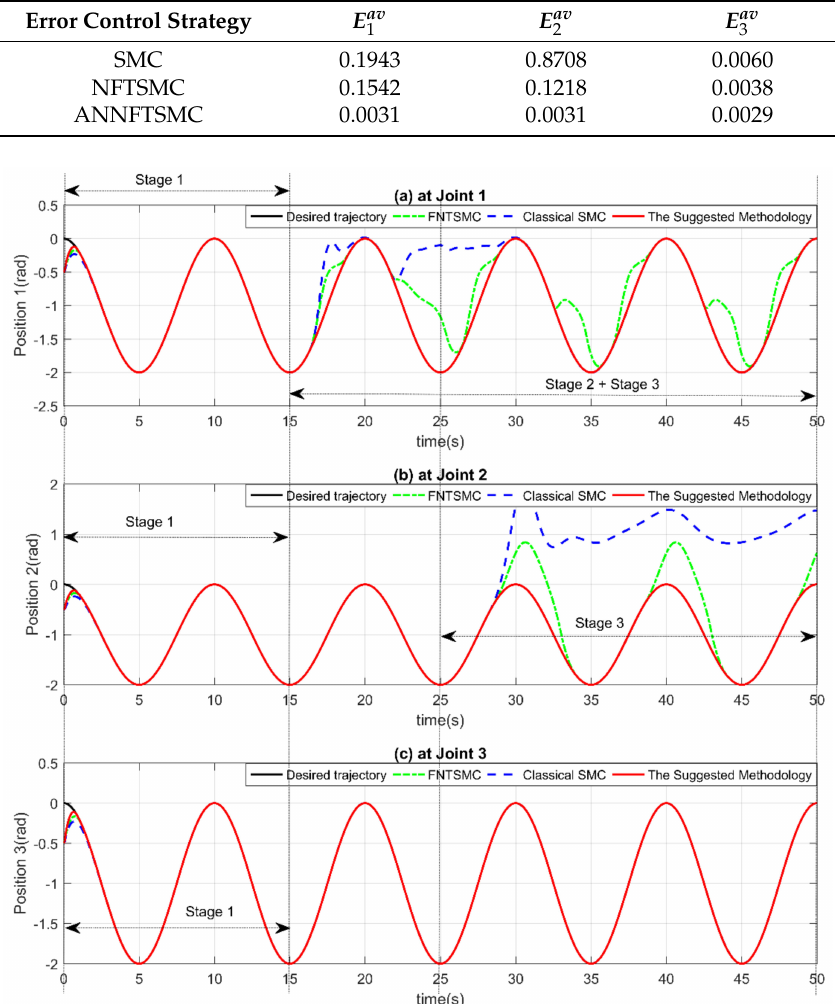
Figure 3. Trajectory tracking positions: ( a ) at Joint 1, ( b ) at Joint 2, and ( c ) at Joint